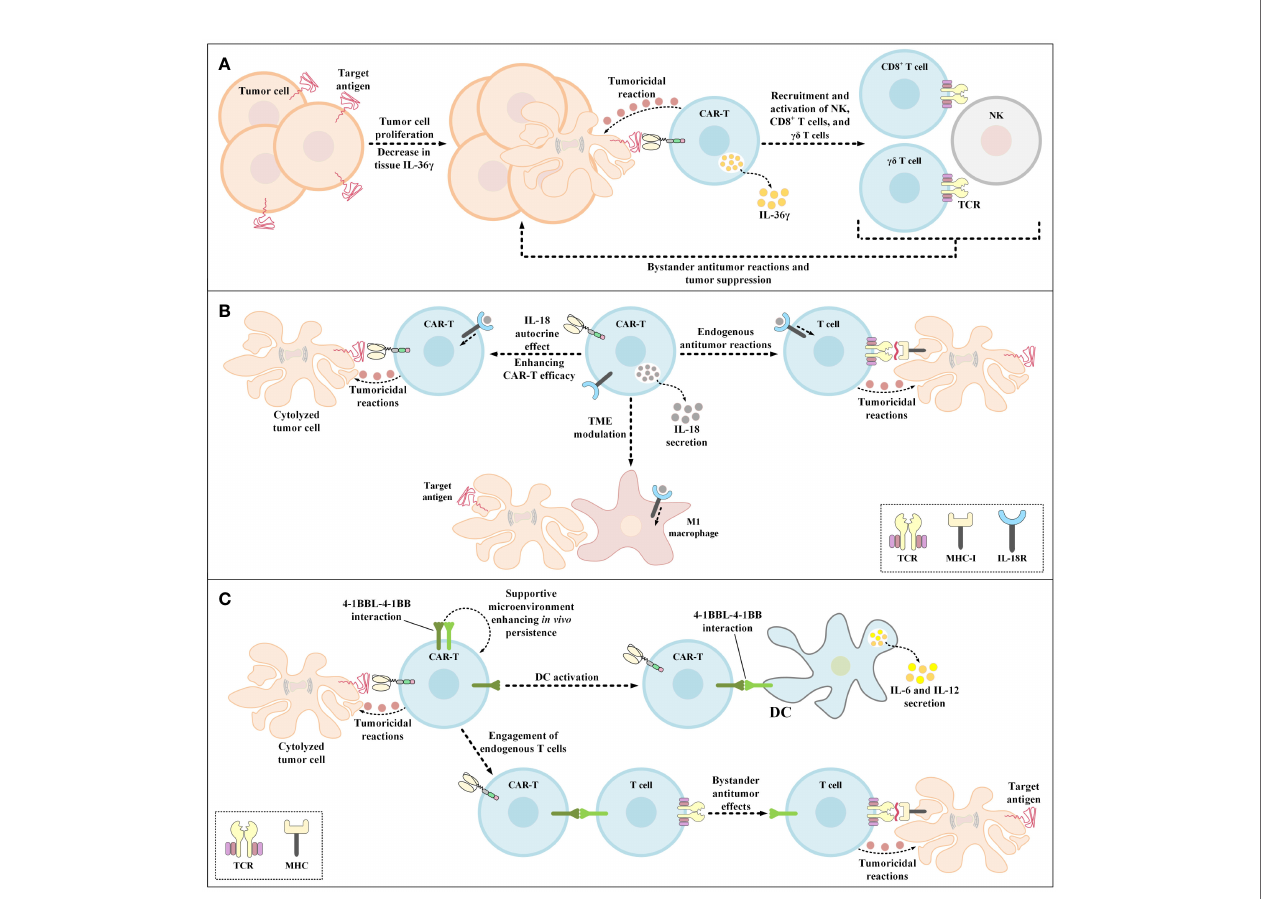
FIGURE 5 | Bystander antitumor effect induction using IL-36 g -secreting CAR-Ts, IL-18-secreting CAR-Ts, and 4-1BBL-expressing CAR-Ts. (A) The effects of IL-36 g secreted by IL-36 g -secreting CAR-Ts. IL-36 g secreted by these engineered CAR-Ts results in the recruitment and activation of endogenous immune effector cells, which include type 1 lymphocytes such as CD8 + T cells, NK cells, and gd T cells. These endogenous immune effector cells can mediate bystander antitumor immune reactions resulting in the suppression of tumor cell proliferation. (B) The effects of IL-18 secreted by IL-18-secreting CAR-Ts. CAR-T-secreted IL-18 has autocrine effects on the CAR-Ts themselves enhancing the antitumor activity of these cells. In case of endogenous tumoricidal effects, CAR-T-secreted IL-18 recruits endogenous T cells to the tumor sites and triggers their bystander antitumor reactions. Moreover, CAR-T-secreted IL-18 also modulates the TME and recruits M1 macrophages to the tumor site which results in M1 macrophage-mediated tumor cell cytolysis. (C) The bene fi cial effects of 4-1BBL expression by CAR-Ts. 4-1BBL- expressing CAR-Ts demonstrate enhanced functionality in comparison with their conventional counterparts in three ways. The 4-1BBL expressed on CAR-Ts self- interacts with the 4-1BB on these cells resulting in their enhanced in vivo persistence. 4-1BBL expressed on CAR-Ts also interacts with 4-1BB on the surface of DCs, inducing DC-secretion of IL-6 and IL-12. Additionally, CAR-T-expressed 4-1BBL interacts with 4-1BB on the surface of endogenous T cells leading to MHC- mediated bystander tumoricidal reactions. 4-1BBL, 4-1BB ligand; CAR, chimeric antigen receptor; DC, dendritic cell; IL-18R, IL-18 receptor; MHC-I, major histocompatibility complex class I; NK, natural killer cells; TCR, T-cell receptor; TME, tumor